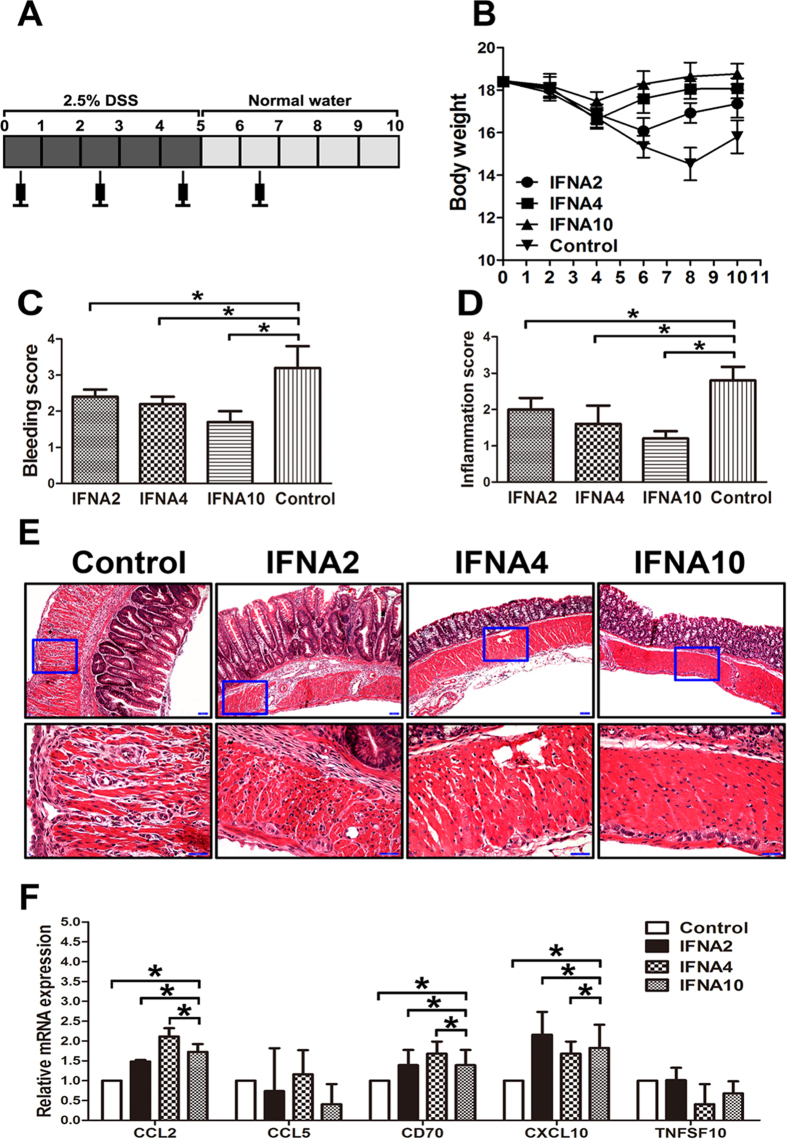
IFNA4 and IFNA10 control DSS-induced acute colitis. (A-B) Left panel showed the experimental protocol applied to induce mice acute colitis and the administration of IFNA subtypes; and right panel showed the mice body weight curve of DSS-induced acute colitis between the study groups. (C) The study mice were monitored for bleeding scores by a quantitative analysis for the presence of rectal blood. (D-E) Colon sections were fixed in formalin and stained with HE; the sections were analyzed for the inflammation score. (F) Real-time PCR analyzed the mRNA expressions of CCL2, CCL5, CD70, CXCL10 and TNFSF10 in colon tissues on DSS model. The data are given as the mean ± SD (n = 10, *P < 0.05).